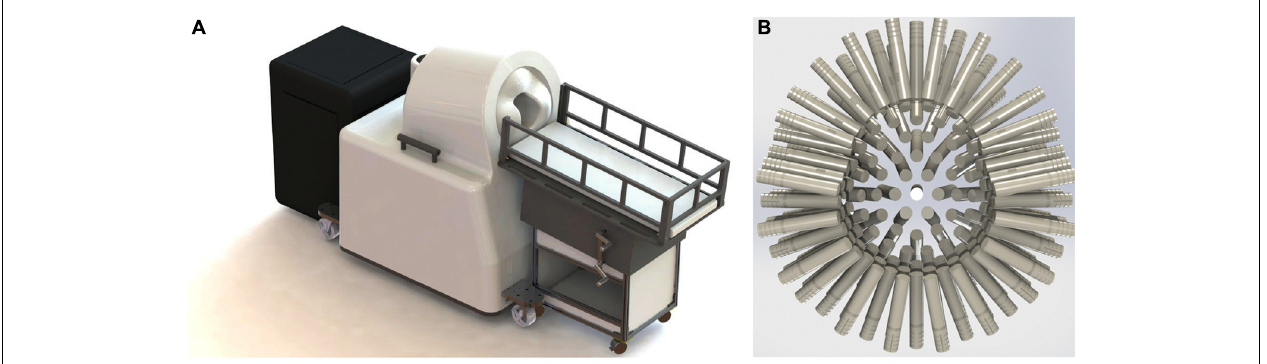
FIGURE 1 | (A) The Tristan Technologies Inc. Artemis 123 biomagnetometer is a member of the babySQUID ® product family (CAD drawing). Shown are the mobile bed, the sensor unit, and cart containing SQUID electronics, all located within the MSR. (B) View of the helmet and